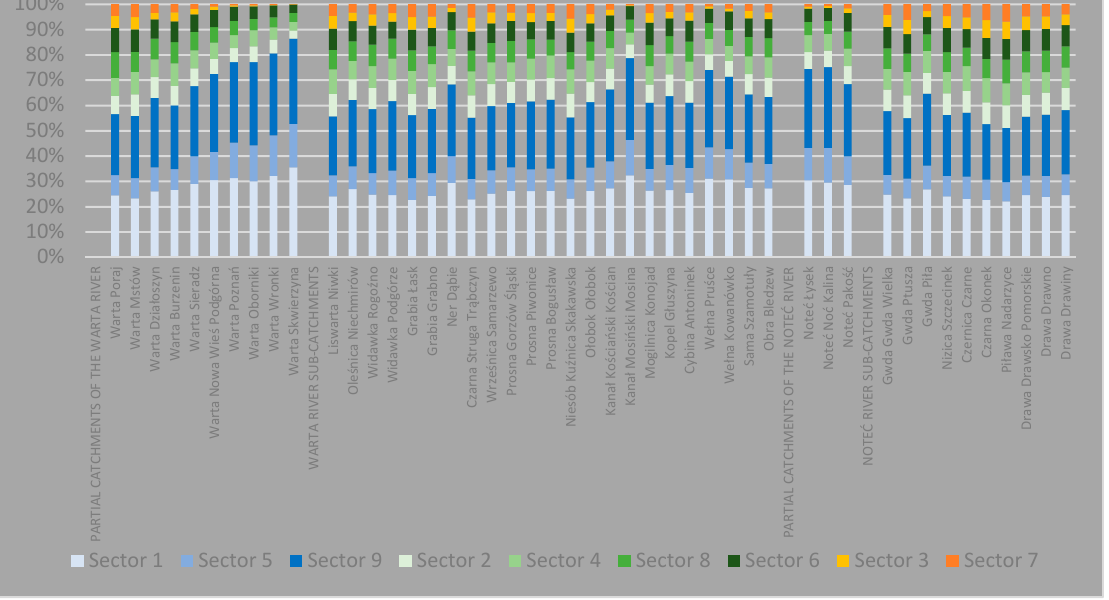
Figure 8. The percent share of separated types of the summer maximum specific runoff (SMAXq) dependencies between analyzed sub-catchments and the Gorzów Wielkopolski gauge closing the Warta River catchment (WRC) (in the hydrographic order).